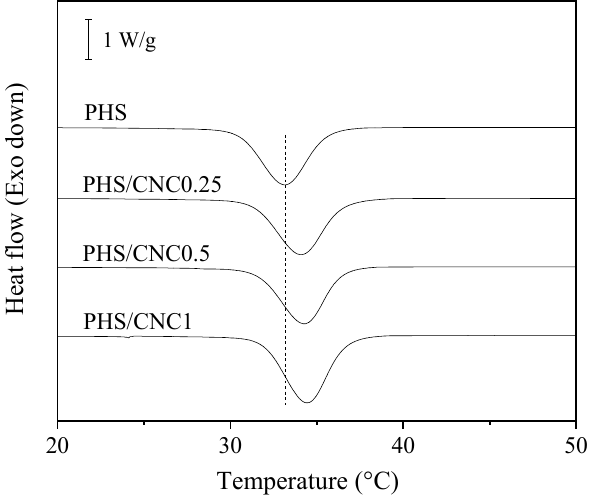
Figure 3. DSC cooling traces of PHS and PHS/CNC composites at 5 ◦ C/min. The isothermal crystallization kinetics of PHS and PHS/CNC composites was also investigated in a crystallization temperature ( T c ) range of 41 to 47 ◦ C after eliminating previous thermal history. Under such an isothermal crystallization condition, the evolution of heat flow with time was recorded and analyzed for both PHS and its composites.